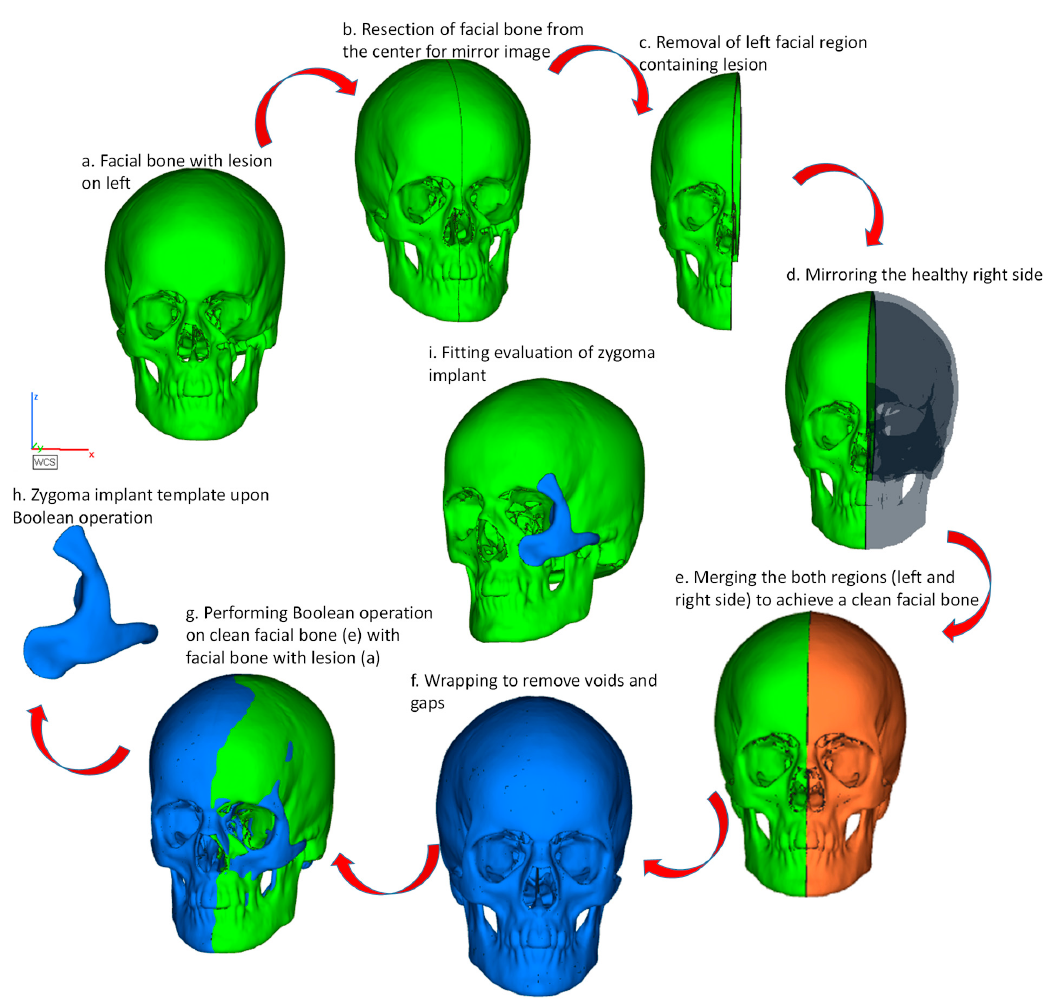
Figure 4. Computer-aided customized zygomatic implant process cycle. ( a ) facial bone with lesion; ( b ) resection of facial bone for mirror image; ( c ) removal of left facial region with lesion; ( d ) mirroring the healthy right side; ( e ) merging both left and right regions to obtain clean facial bone; ( f ) wrapping operation to remove gaps; ( g ) boolean operation between clean facial bone and facial bone with lesion; ( h ) obtained zygomatic bone template upon Boolean operation; ( i ) fitting evaluation of zygoma implant.